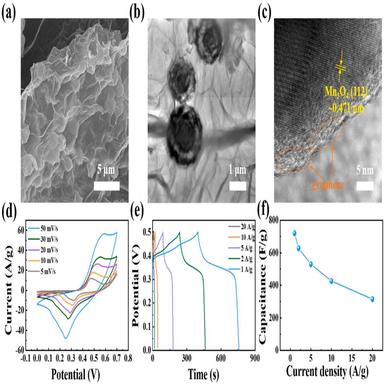
a) SEM image, b) and c) TEM image, d) HRTEM image of Mn3O4-rGO; d) CV curves of Mn3O4-rGO at different scan rates. e) Galvanostatic charge/discharge curves of Mn3O4 rGO at different current densities. f) specific capacitances of Mn3O4-rGO at different current densities.